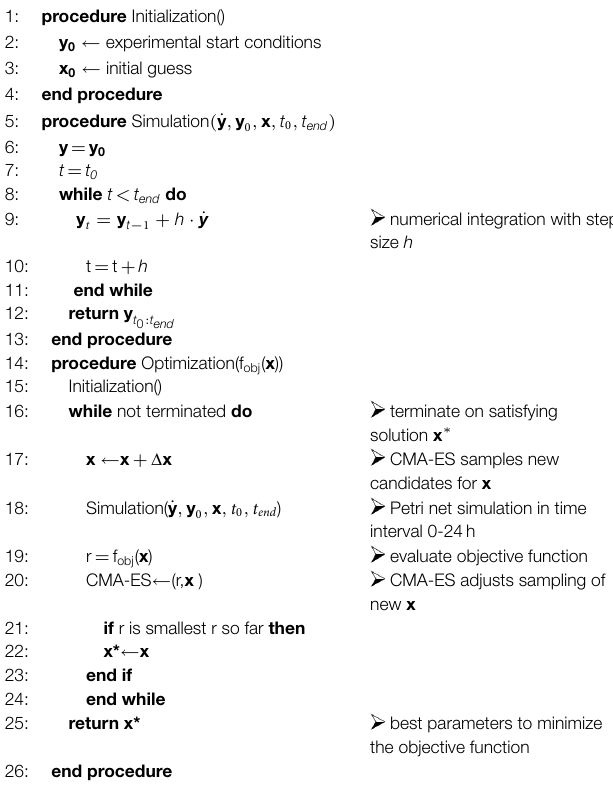
Theyareconstructedaccordingtothegivendefinitionin Figure8 forgeneralmassactionkinetics.TwospecialinhibitingtransitionsareinspiredbyMichaelis–Menteninhibition(37).These are connected by red bidirectional arcs to TNF- α within the Petri net ( Figure 1 ). x i ’s are unknown, hence arbitrary selectable, parameters which will be used for optimization. Optimized parameters and constant terms c 1 to c 8 , which are added to establish an equilibrium initial state, are given in the online supplementary. HS, heparan sulfate; PARP, poly-(ADP-ribose) polymerase; ERK, extracellular signal-regulated kinase; RIP, receptor-interacting protein; TNF- α , tumor necrosis factor alpha. ALGORITHM 1 | Optimization